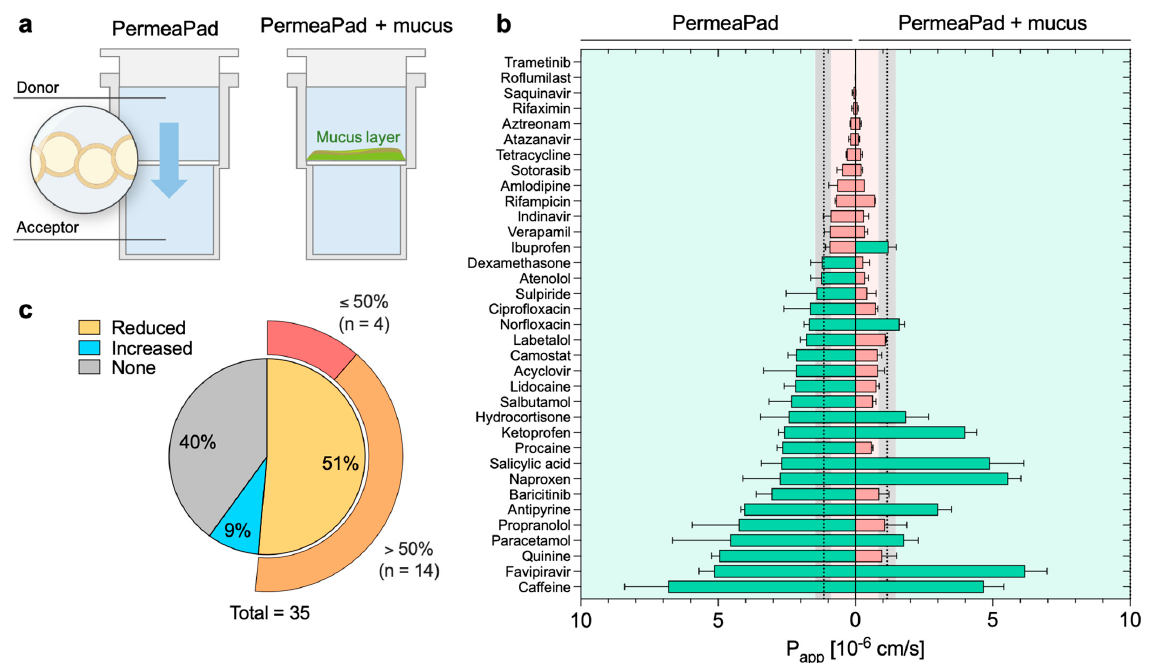
Figure 5. Coupling of a cystic fibrosis mucus model to the PermeaPad 96-well plate and its effect on permeability. ( a ) Graphical illustration of the different permeation setups in the absence and presence of the cystic fibrosis mucus model. ( b ) Impact of mucus on the apparent permeability of the investigated compounds. The binary color code distinguishes between high- (green) and low- (red) permeability drugs. The threshold, 1.15 (± 0.32) × 10 − 6 cm/s, is represented by the gray area. ( c ) Pie chart of the impact of mucus grouped by its overall effect on permeability compared to controls (i.e., absence of mucus). Magnification highlights the subclassification within the reduced-permeability group.